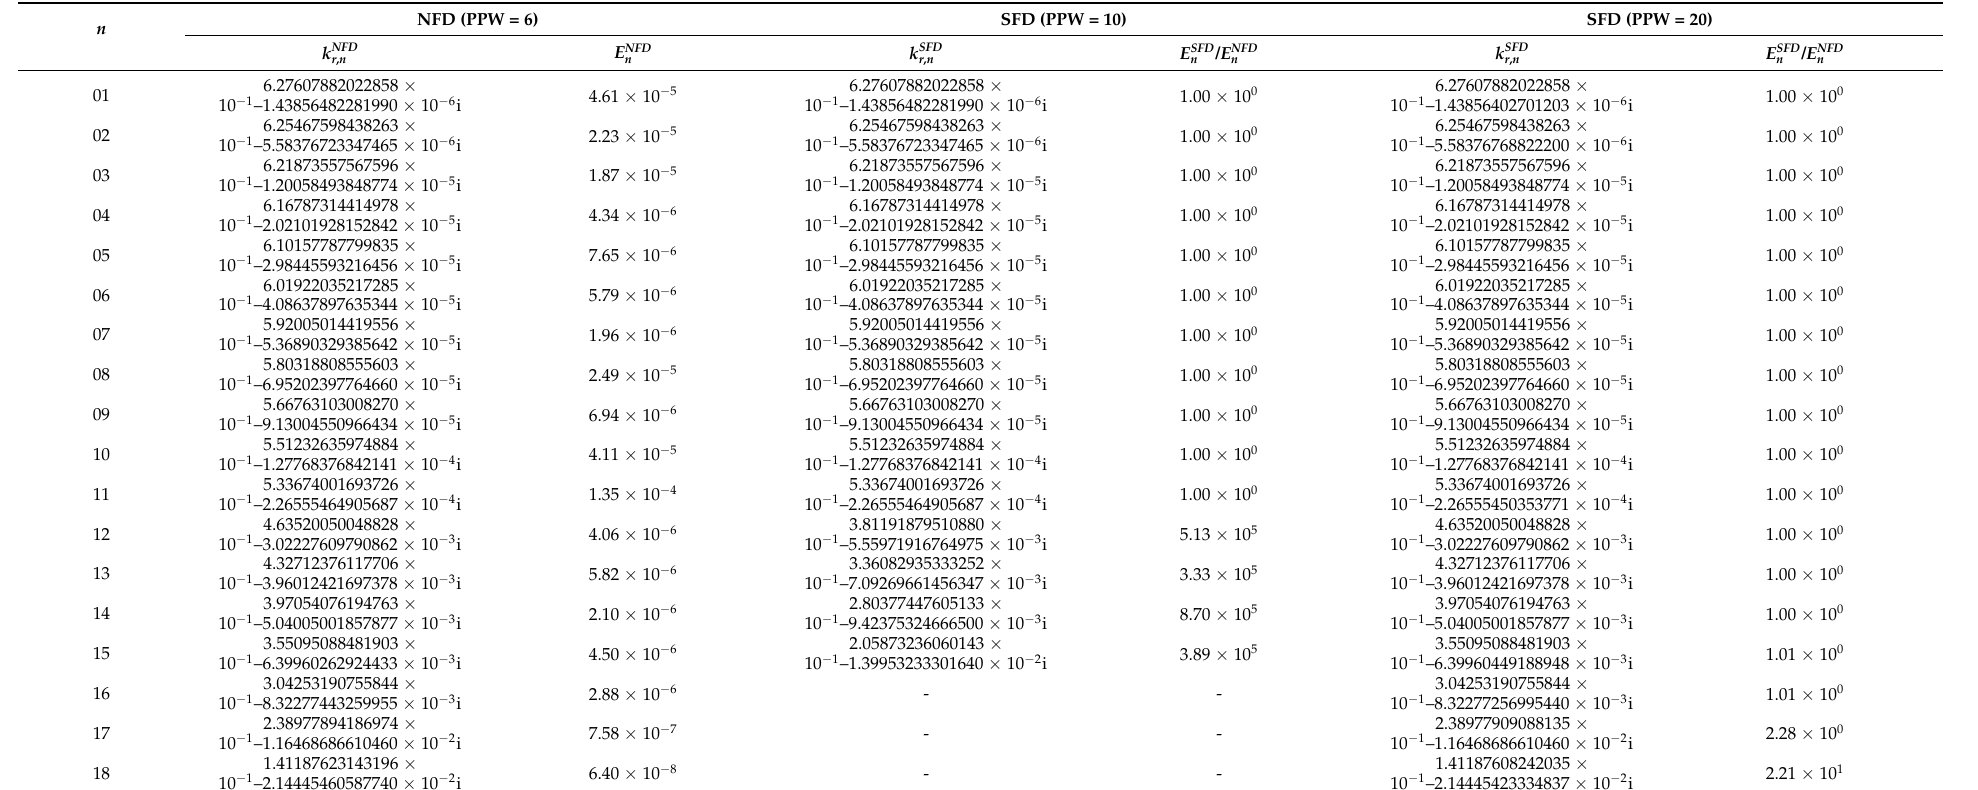
Table 1. Approximate eigenvalues and their numerical errors in the Pekeris waveguide